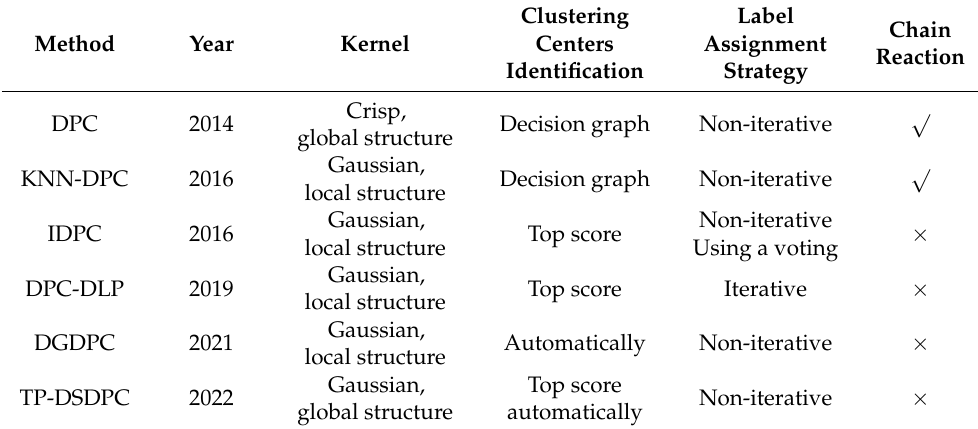
Table 1. Comparison of various clustering